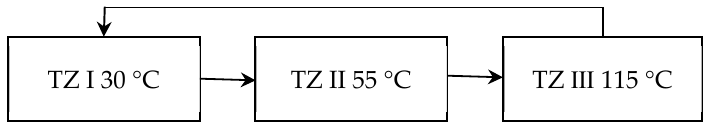
Figure 10. Physical configuration of the PCR process.